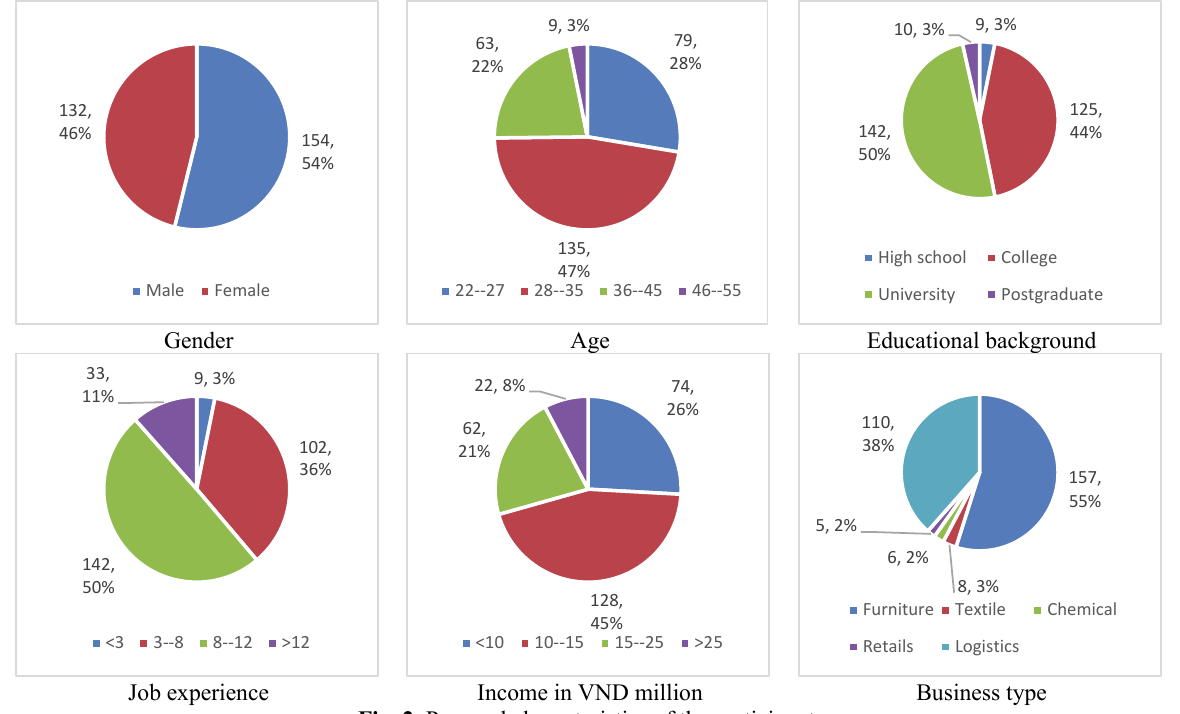
Fig. 2. Personal characteristics of the participants